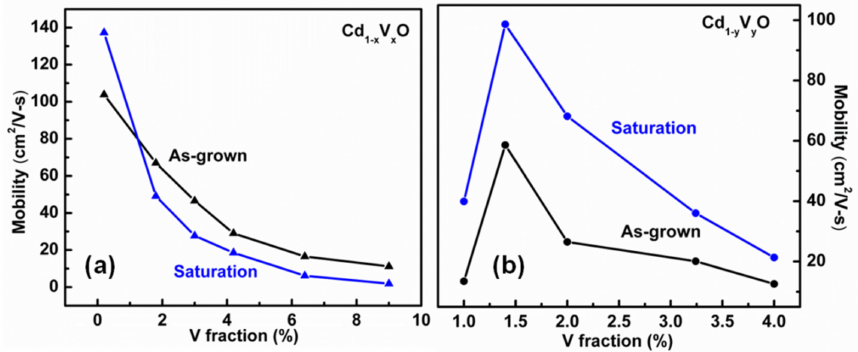
Figure 5. As-grown and saturated mobility in Cd 1 − x V x O (x = 0.2~9%) ( a ) and Cd 1 − y V y O (y = 1~4%) series ( b